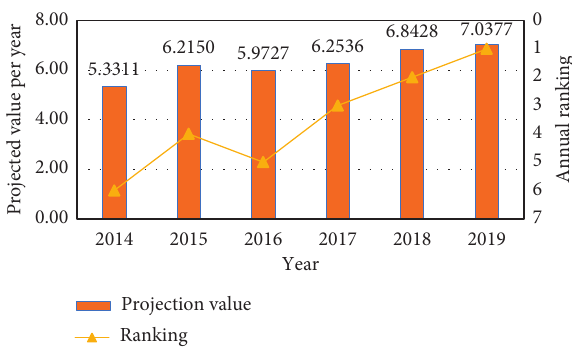
Figure 4: Projected values and ranking of comprehensive social impact assessment.